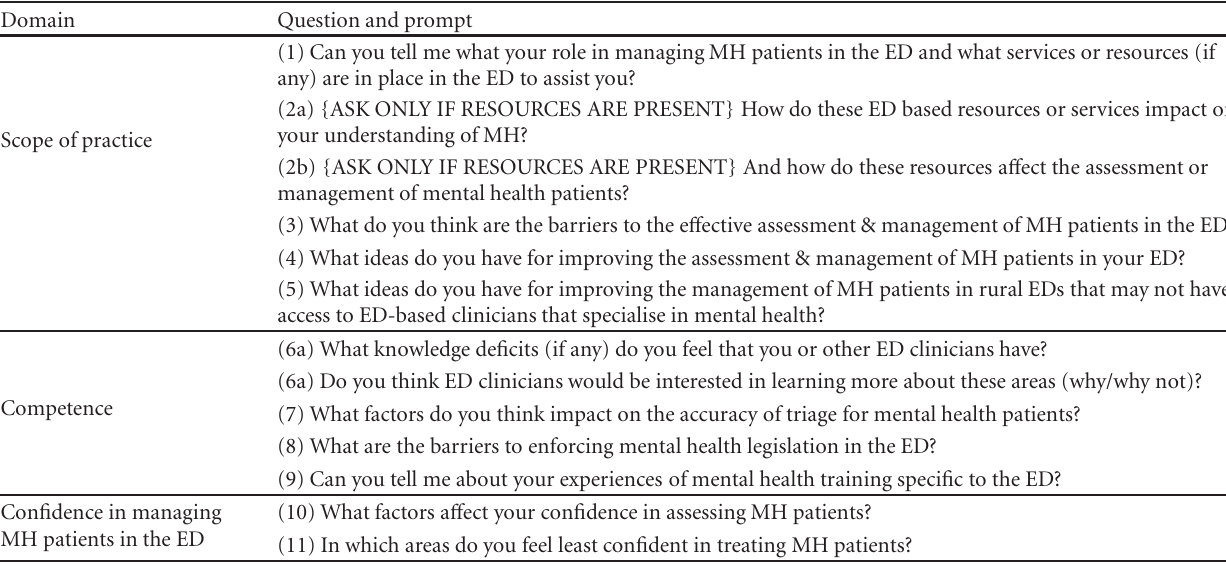
Table 1: Identifying the mental health learning needs of emergency clinicians: interview schedule.